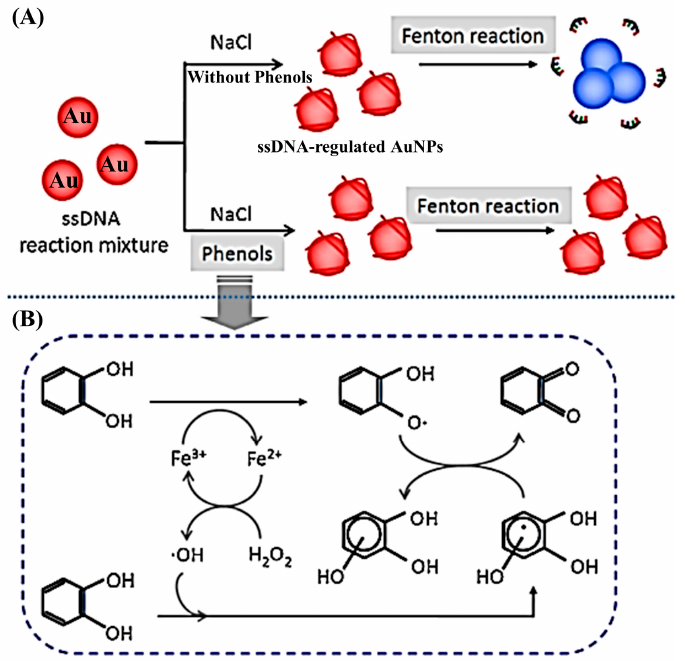
Figure 2. ( A ) AuNP-based colorimetric sensor for phenols’ detection by means of Fenton reaction. ( B ) Schematic diagram of the mechanism of catechol oxidation owing to OH free-radicals generated from Fenton reagents. Adapted from [65]. Colorimetric detection of bisphenol A has been successfully performed using specific aptamer-based and cationic polymer-assisted GNP aggregation with a limited detection as low as 1.50 nM [66]. In contrast, an aptasensor-based and GNP-assisted colorimetric technique has been developed for ultra-sensitive detection of bisphenol A. In this study, the authors have reported that GNPs have been modified with the two types of specific aptamers as truncated 38-mer and 12-mer, leading to the limits of bisphenol A detection of 7.60 pM and 14.41 pM, respectively [67]. On the other hand, elliptical or sphere shapes